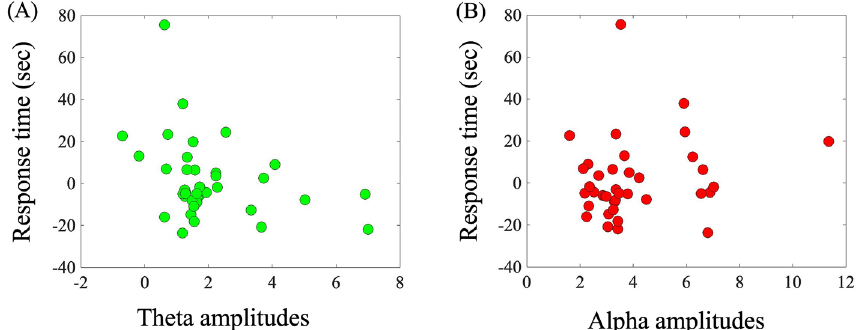
Figure 5. Relationship between response time (RT) and oscillatory amplitude induced by repetitive transcranial magnetic stimulation (rTMS) conditions. ( A ) Scatter plots between RT and the theta amplitude under the theta- TMS condition. ( B ) Scatter plots between RT and the alpha amplitude under the alpha-TMS condition.